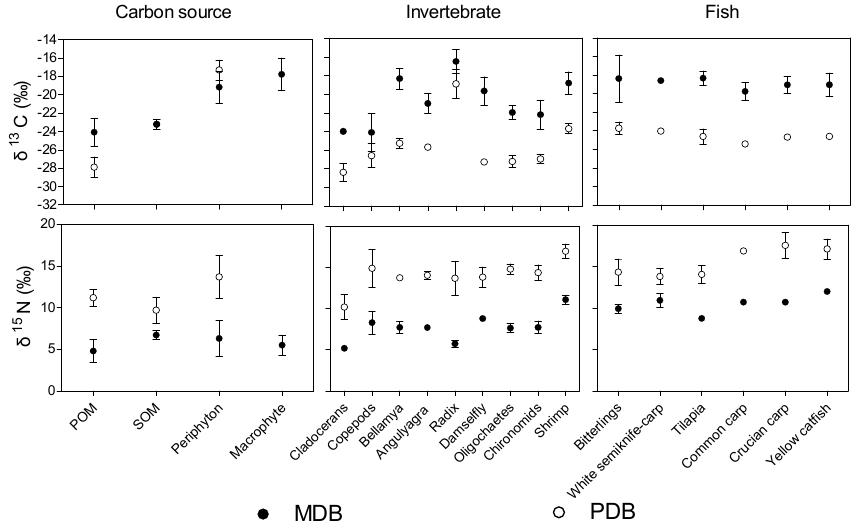
Figure 3. Mean δ 13 C and δ 15 N values (±SD) of food sources, invertebrates, and fish in MDB and PDB during the period April 2010 to March 2011.